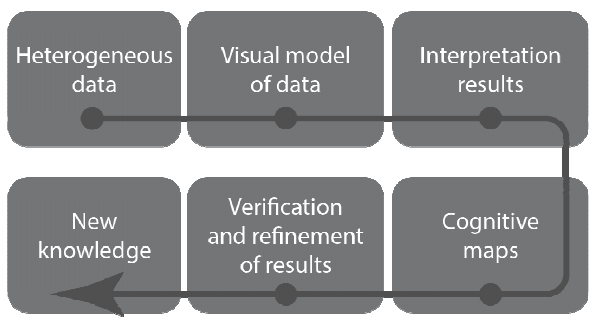
Fig. 1. Heterogeneous data interpretation